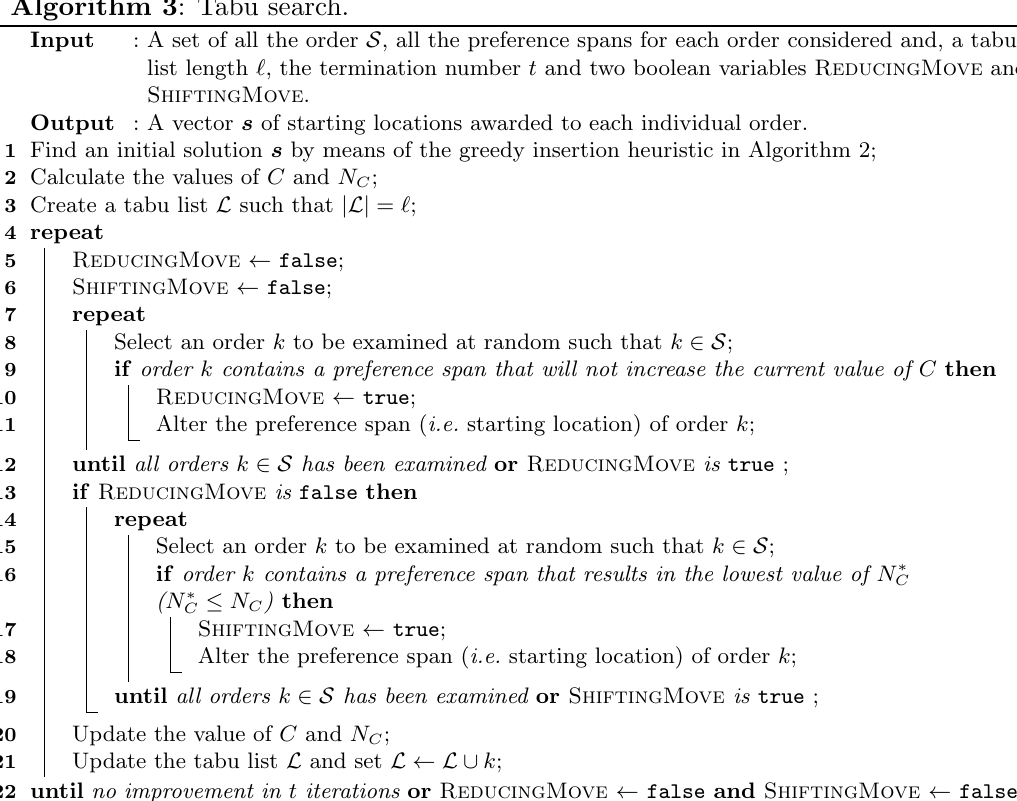
Algorithm 3 : Tabu